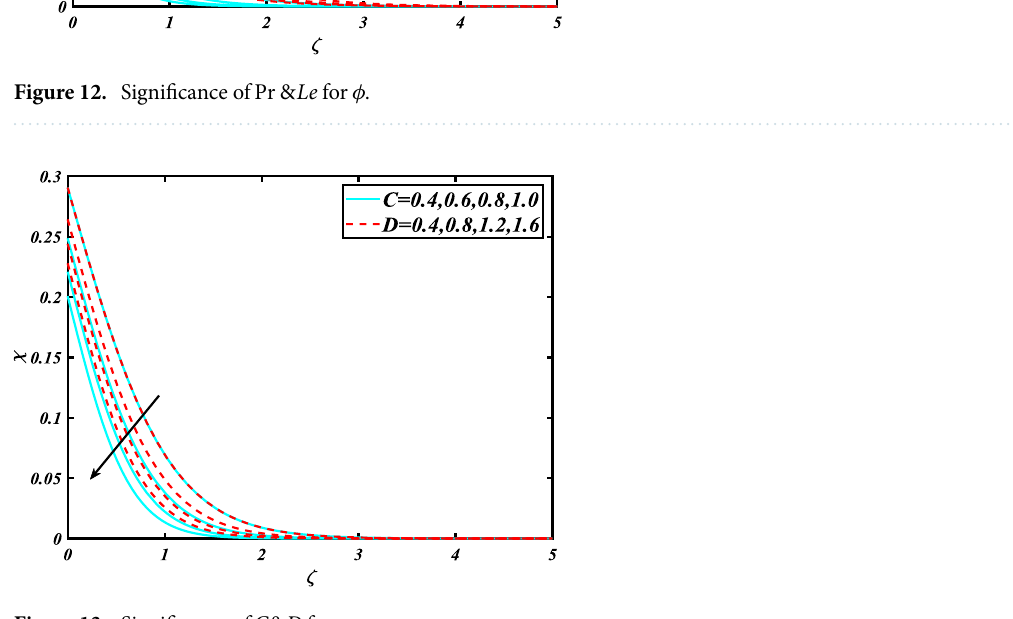
Figure 13. Significance of C & D for χ